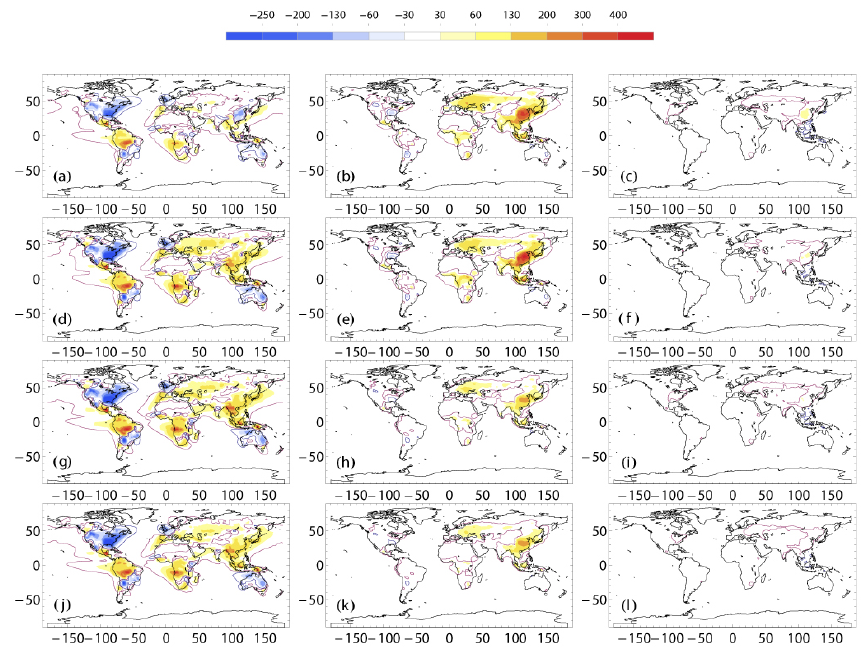
Fig. 4. Change in number of activated cloud droplets (in cm − 3 ) attributable to changes in accumulation mode aerosol properties. (a–c) δN d due to change in aerosol number (a) , aerosol volume (b) , and aerosol hygroscopicity (c) for simulation with the ARG parameterization. (d–f) Same as above, but for the simulation using ARG α . (g–i) Simulations with FN and (j–l) simulations with